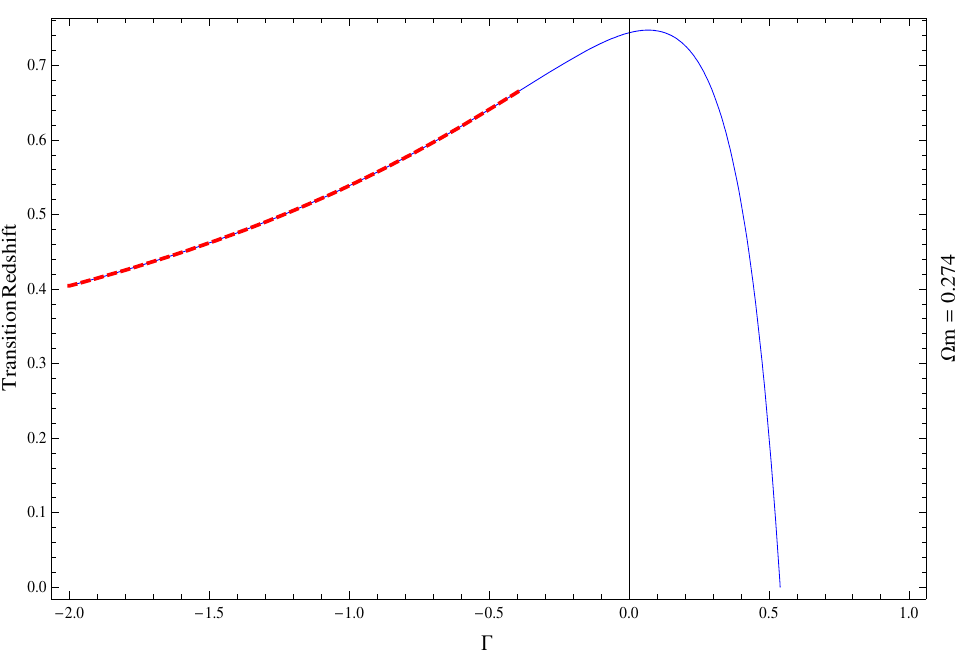
Figure 3. The transition redshift, z tr , in the polytropic DM model in terms of the associated exponent, Γ (blue solid curve). For Γ ≤ − 0.38 (red dashed curve), the universe enters into the phantom realm